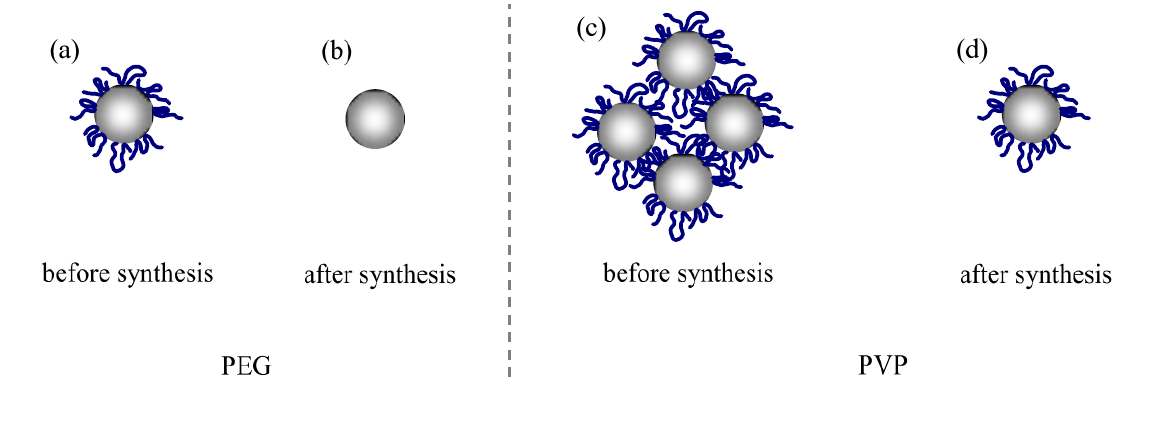
Figure 6. Schematic of ZnO nanoparticles capped by polymer molecules: ( a ) PEG was added to the ZnO solution before synthesis; ( b ) PEG was added to the ZnO solution after synthesis; ( c ) PVP was added to the ZnO solution before synthesis; ( d ) PVP was added to the ZnO solution after